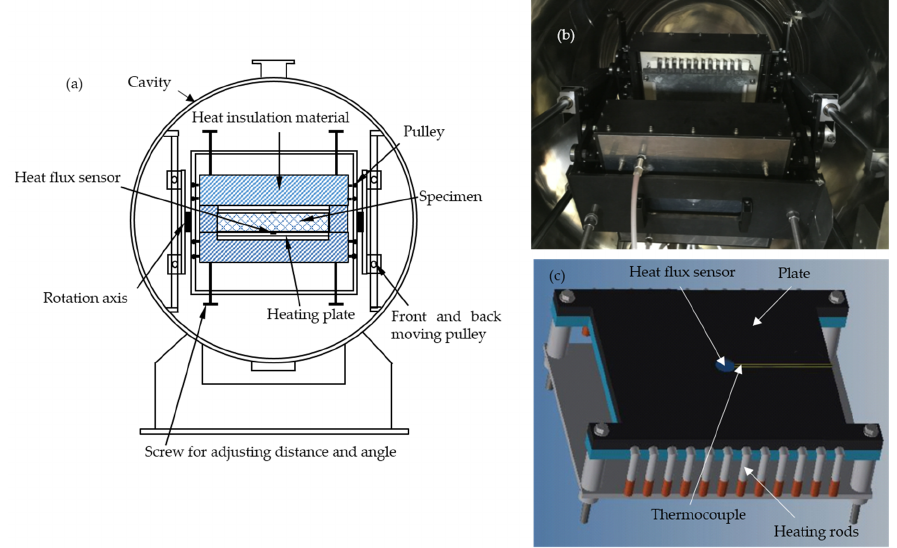
Figure 1. Structure of the measurement apparatus. ( a ) Diagrammatic sketch, ( b ) photograph, and ( c ) heating plate.